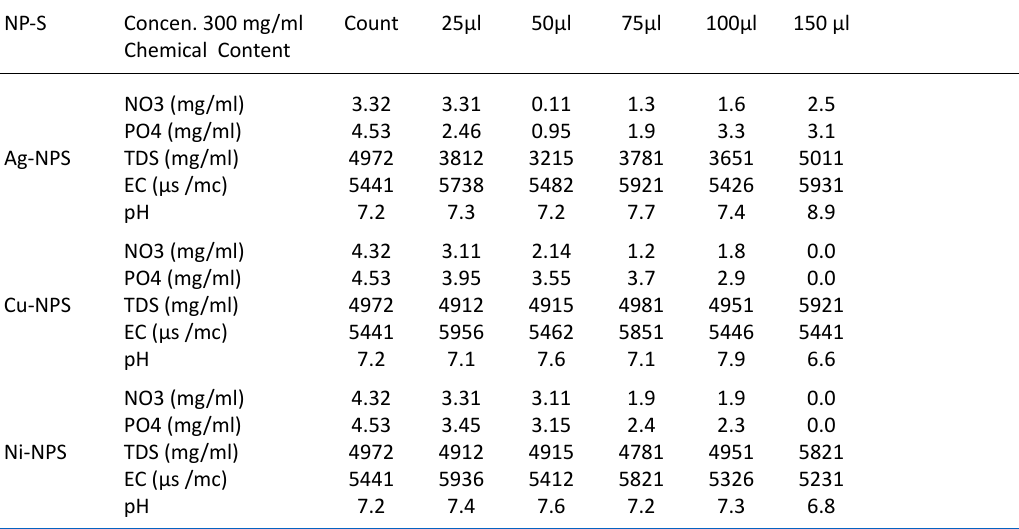
Table 4. Effect of Ag-NPS, CU-NPS, Ni-NPS, synthesized by ginger on chemical and physical properties of El Kilo21 lake water sample